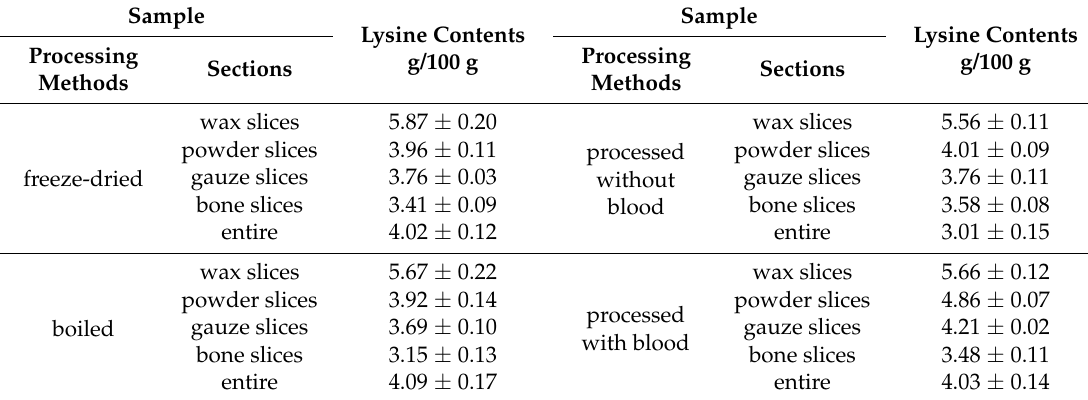
Table 5. Lysine contents in different sections of antler velvet with different processing methods which were determined by amino acid automatic